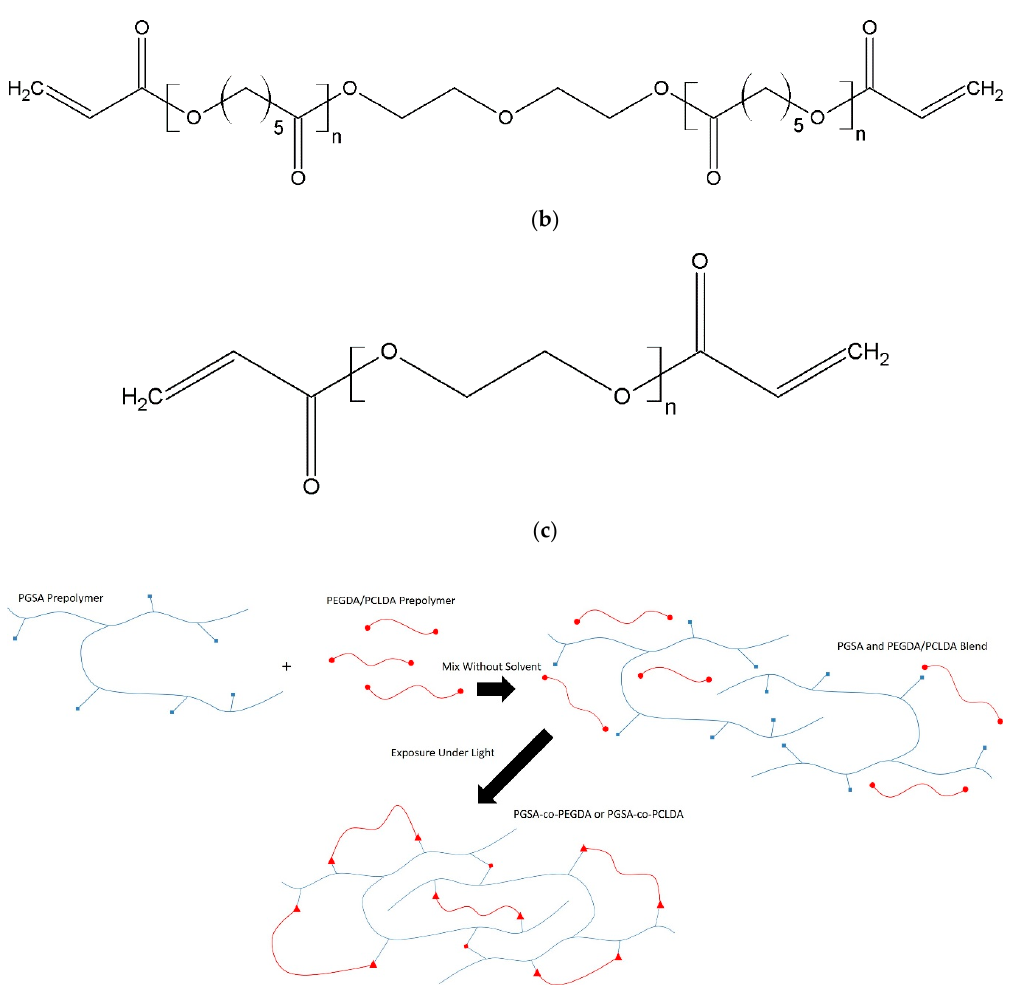
Figure 3. ( a ) General structure of PGSA where x indicates the degree of acrylation. ( b ) Structure